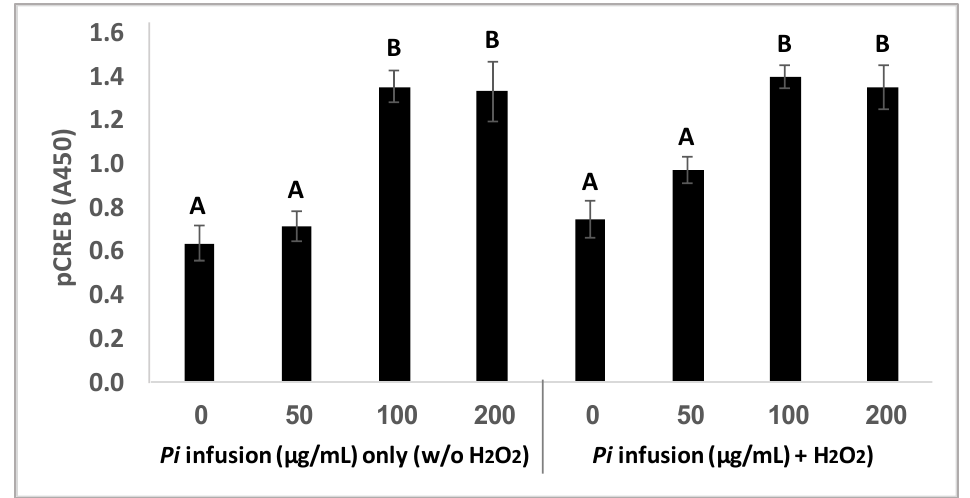
Figure 7. Pi infusion upregulates cyclic AMP response element-binding protein (CREB) phosphorylation. Cells were pretreated for 2 h with increasing concentrations of Pi infusion. H 2 O 2 (200 µM) was then added, and pCREB levels in cell lysates (25 µg) were determined 30 min later. The results are presented as mean ± SEM of three experiments performed in duplicates ( n = 6) and were analyzed by one-way ANOVA followed by the Tukey–Kramer multiple comparison test. Columns marked with different letters (A, B) represent statistically significant differences p < 0.001. Mice Alterations in the intracellular redox ratio during aging appear to be highly localized to the brain hippocampus [36,37]. We, therefore, examined whether Pi infusion has a neu- roprotective effect in vivo by preventing neuronal mortality in the hippocampus of aging mice. Figure 8a. demonstrates that after 18 months of daily treatment with Pi infusion- supplemented drinking water, mouse brains contained a significantly reduced percentage of pycnotic cells in the CA3 and DG (70% and 83% reduction, respectively) . In the DG area, 600 mg/kg Pi infusion also significantly enhanced the number of vital neuronal cells by more than 50% (Figure 8b).